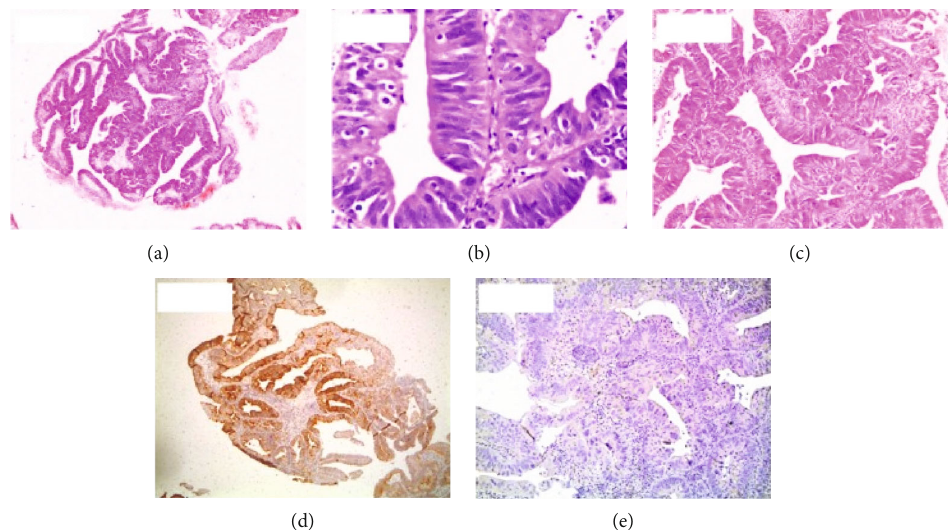
Figure 2: (a) Intestinal-type carcinoma with a tubulopapillary pattern (hematoxylin-eosin, 100x). (b) Intestinal-type carcinoma with minimal nuclear atypia (hematoxylin-eosin, 400x). (c) Intestinal-type carcinoma with the absence of desmoplasia (hematoxylin-eosin, 400x). (d) Intestinal-type carcinoma with CK20 positivity (immunohistochemistry, 100x). (e) Intestinal-type carcinoma with CK7 negativity (immunohistochemistry,